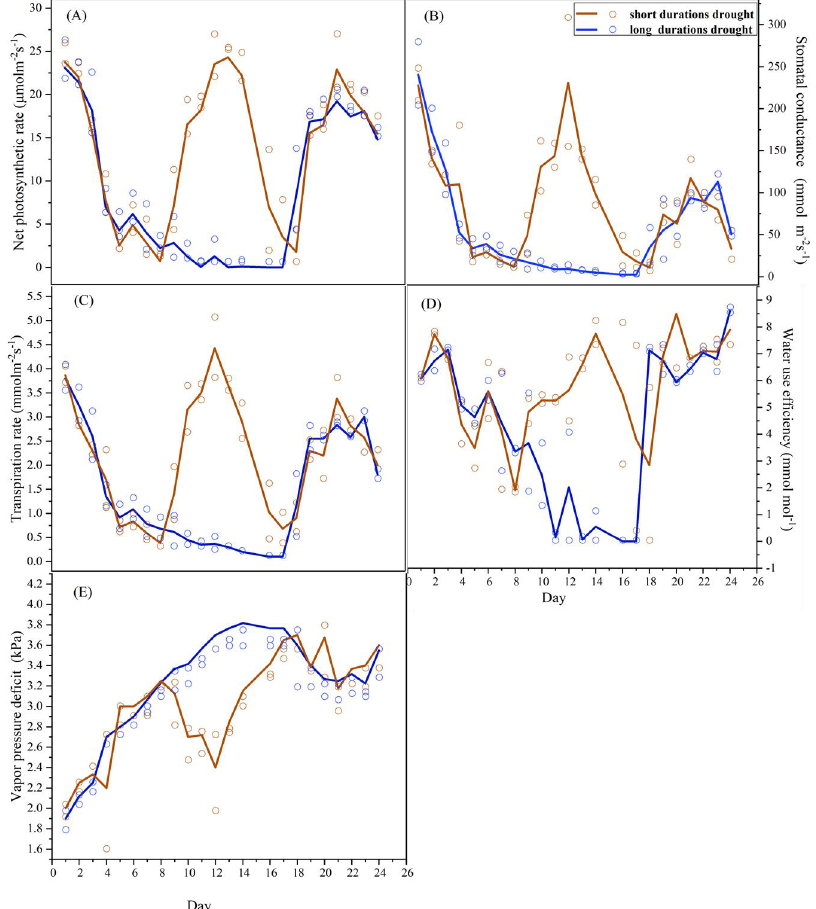
Figure 2. The changes in net photosynthetic rate, stomatal conductance, transpiration rate, water use efficiency, and vapor pressure deficit during short and long durations of drought rehydration cycles. ( A ). The changes in net photosynthetic rate in short and long durations of drought rehydration cycles. ( B ). The changes in stomatal conductance in short and long durations of drought rehydration cycles. ( C ). Changes in transpiration rate in short and long durations of drought rehydration cycles. ( D ). Changes in water use efficiency in short and long durations of drought rehydration cycles. ( E ). The changes in vapor pressure deficit in short and long durations of drought rehydration